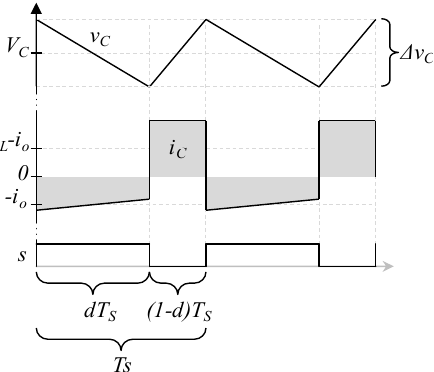
Figure 5. Important waveforms to calculate the average current through the capacitor, the switching function s , the current through capacitor function, and the capacitor’s voltage, with a zoom-in to observe the ripple.